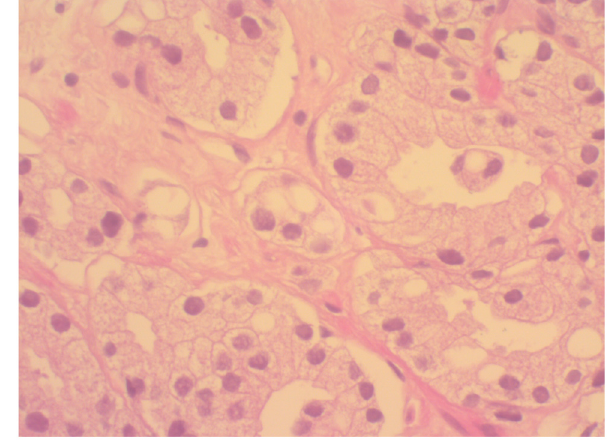
Figure 1. Breast carcinoma showing an adenocarcinoma with marked nuclear pleomorphism. (H&E stain, X400